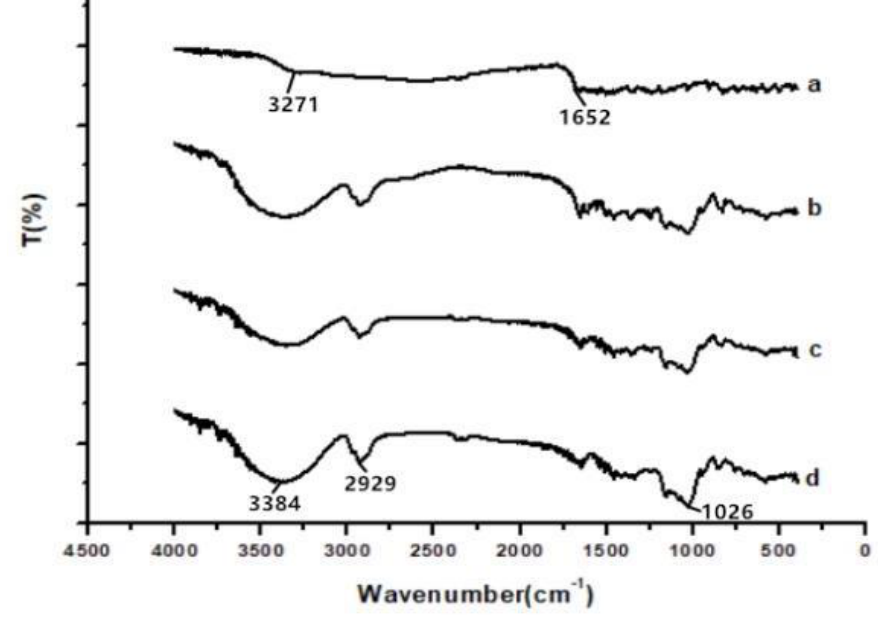
Figure 5. FTIR results of samples. (a) Raw API, (b) API nanoparticles, (c) API and HP- β -CD mixture, and (d) HP- β -CD.